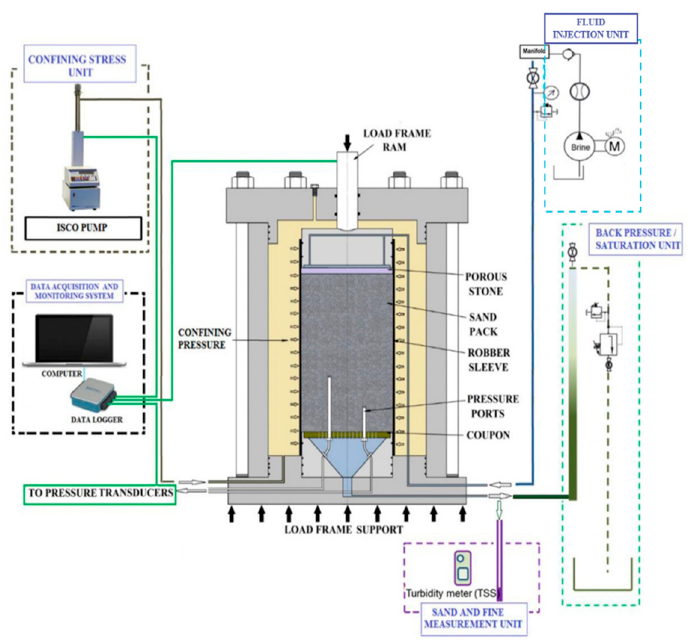
Figure 2. Schematic view of the scaled completion test (SCT) facility.